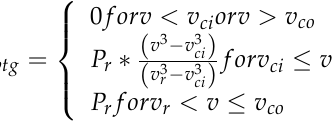
where rate power p r = 0.5 C p . ρ a . η g . A w . v 3